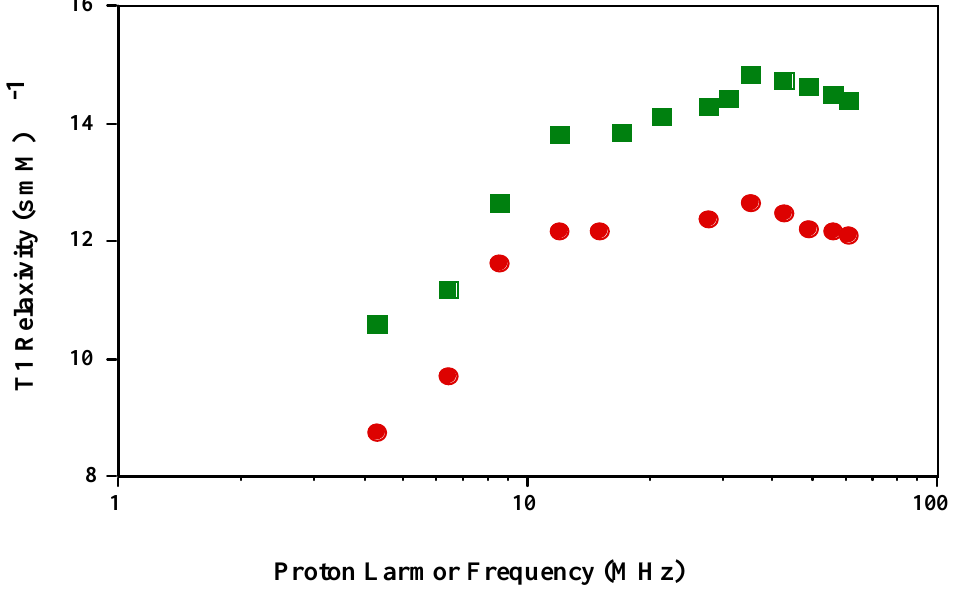
Figure 1. T1 NMRD profiles of MnT(2-C)PP and MnT(4-S)PP in PBS (pH 7.4; 23 oC).